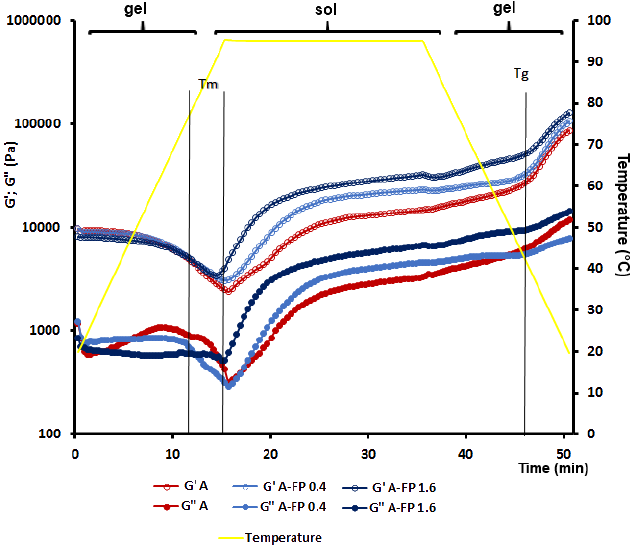
Figure 4. Temperature ramp tests performed at constant frequency (1.0 Hz) for A, A-FP0.4, and A-FP1.6 gels. An initial heating step (5 °C/min from 20 to 95 °C) was followed by an isothermal step (95 °C, 20 min) and a final cooling step (rate: 5 °C/min from 95 to 20 °C).